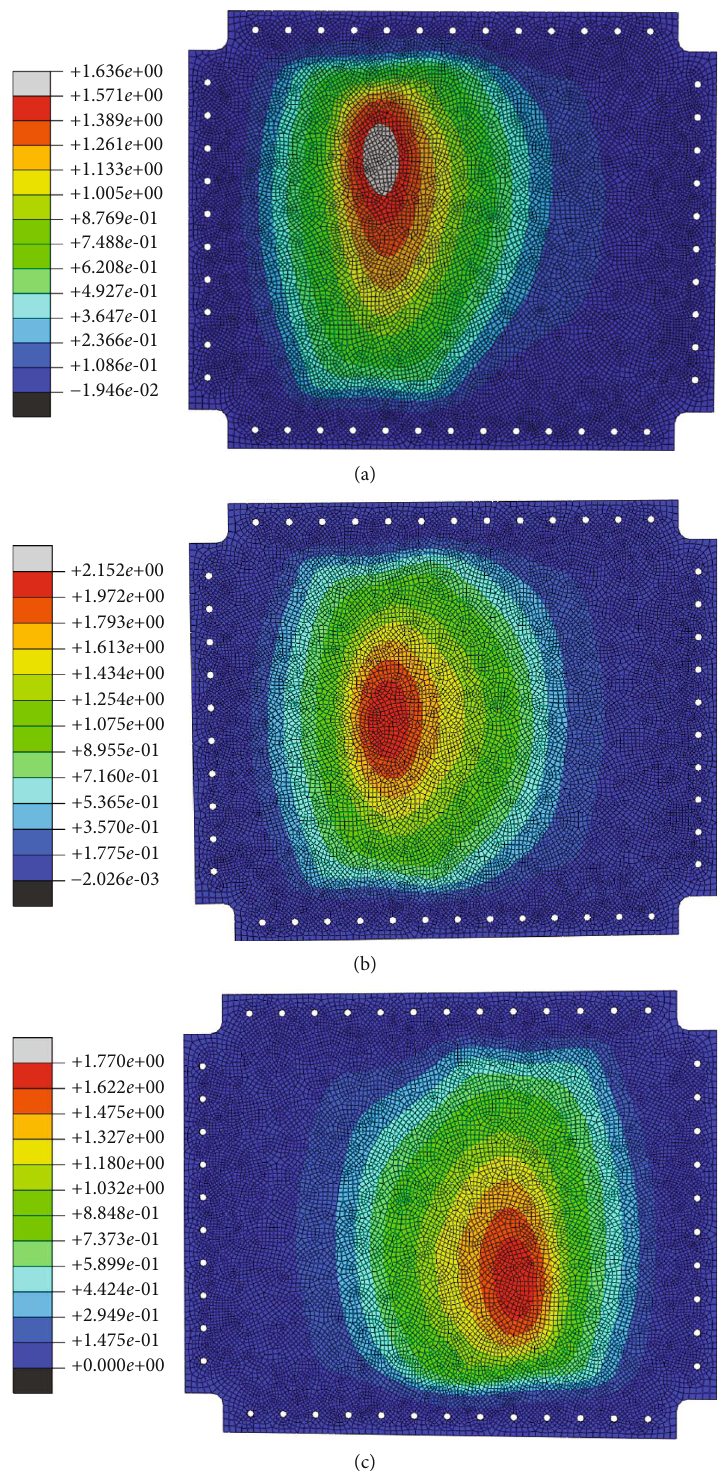
Figure 12: Cloud of skin displacement at di ff erent impact points. (a) Impact point A. (b) Impact point B. (c) Impact point